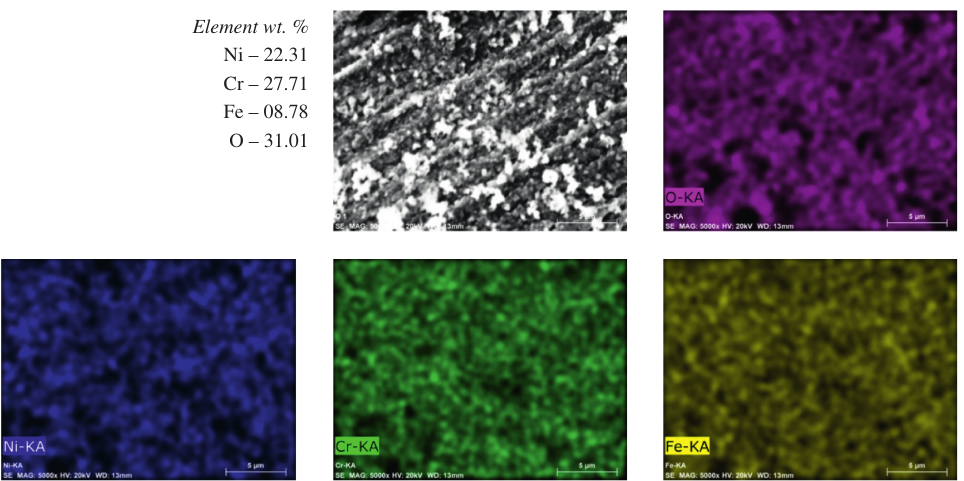
Figure 7: SEM, EDS and image mapping of the alloy X exposed to air at